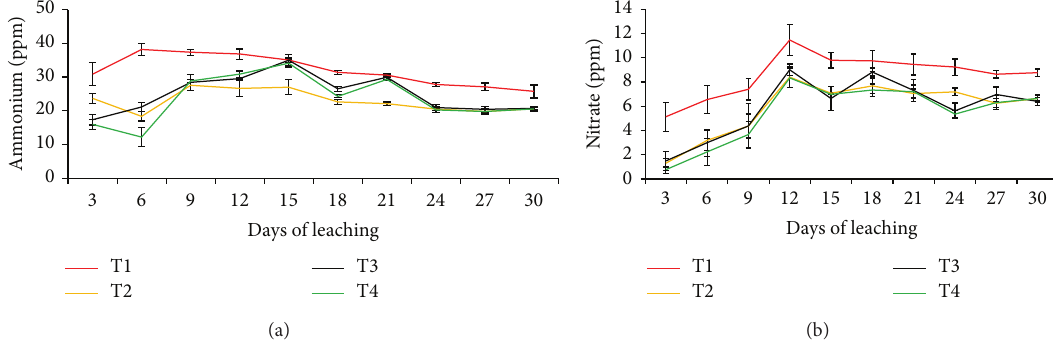
Figure 6: Ammonium and nitrate leached at three-day interval over 30 days of leaching for T1, T2, T3, and T4 effects only. Note . T1: 64g soil + 7.40g urea (no additives); T2: 64 g soil + 7.40g urea + 6g clinoptilolite zeolite; T3: 64 g soil + 7.40 g urea + 1.54 g compost; T4: 64g soil